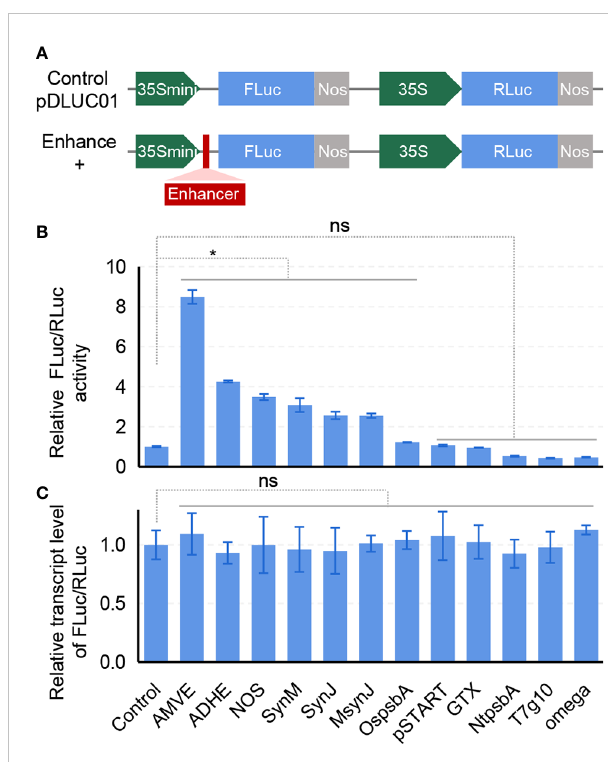
FIGURE 1 Screening of translational enhancers in rice protoplasts. (A) Diagram of the dual-luciferase plasmid pDLUC01. FLuc, fi re fl y luciferase. RLuc, R. reniformis luciferase. The insertion site for enhancer sequences was marked as a red box. (B) Assessment of enhancers in protoplast-based dual-luciferase assays. RLuc was used as an internal control. (C) Transcript levels of FLuc/RLuc in rice protoplasts. (B, C) All values represent means ± s.d. of three independent experiments (n = 3). * P < 0.05; ns, no signi fi cant difference (two-tailed Student ’ s t